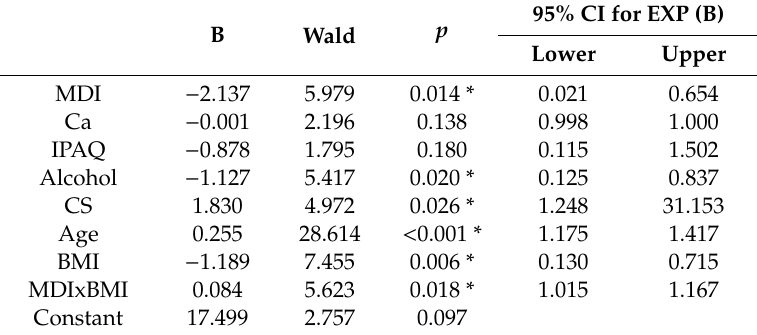
Table 4. Results of the adjusted binary logistic regression